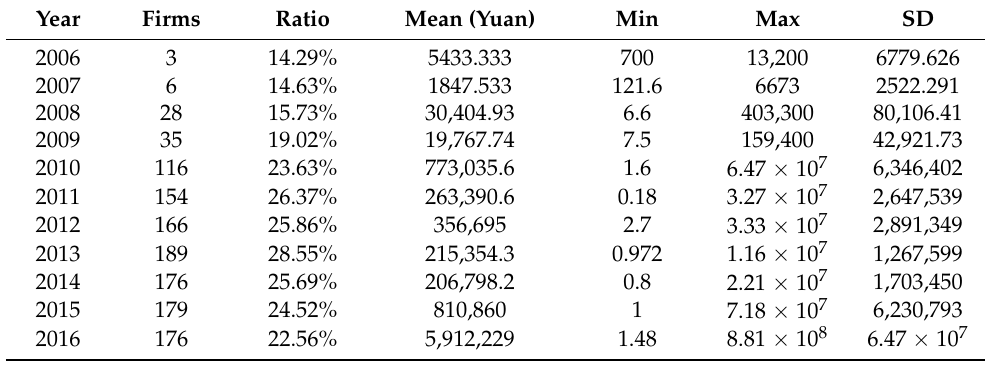
Table 3. Amount of environmental investment.